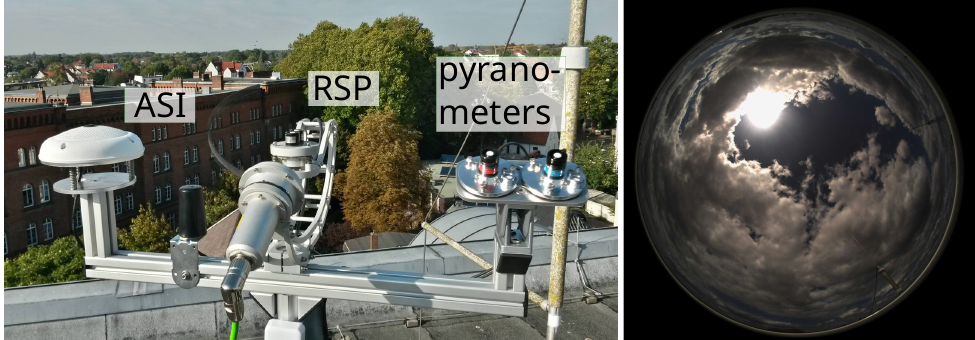
Figure 2. At station DON (located in the center of Oldenburg, left panel), an all-sky imager (ASI), a rotating shadowband irradiometer (RSI) and tilted pyranometers (from left to right) are set up. ASI and RSI provide input data to the analysis. The right panel shows an exemplary ASI image with 180 ◦ field of view taken at DON on 14 May 2020 12:27:00 UTC. Image source left image: Thomas Schmidt,